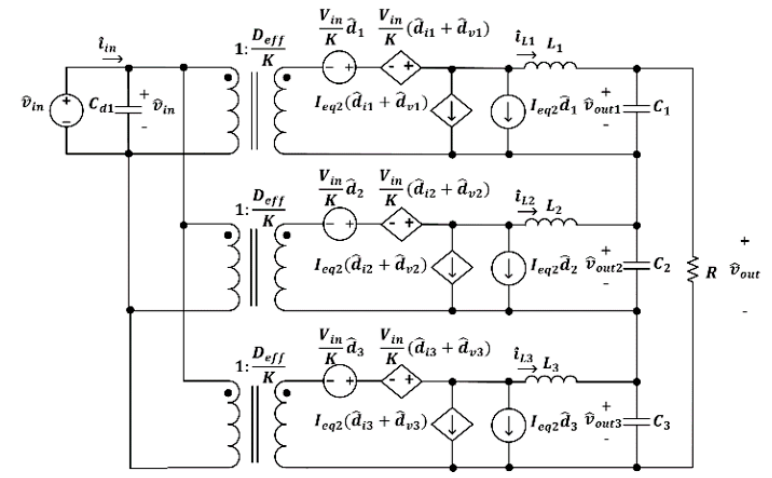
Figure 6. IPOS DC-DC converter SSM.